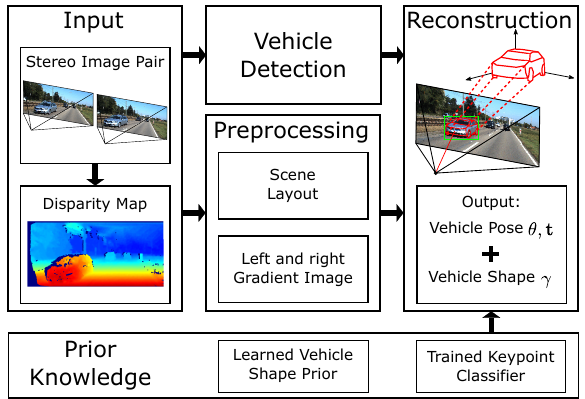
Figure 1. Overview of our